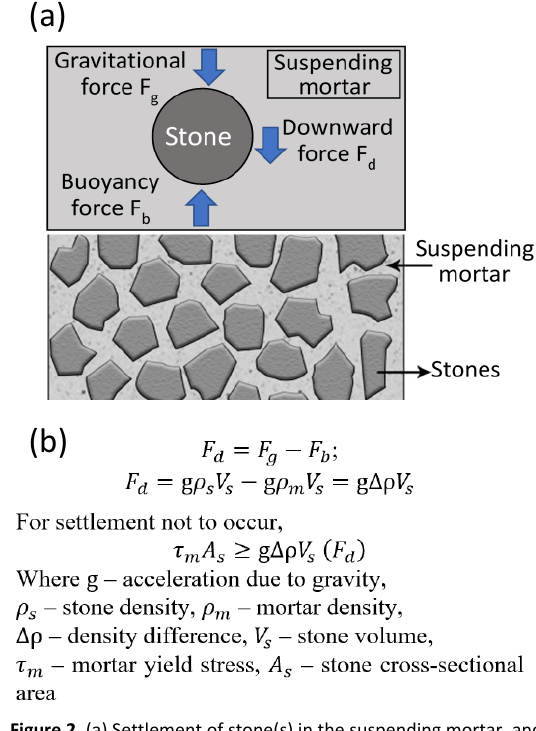
Figure 2. (a) Settlement of stone(s) in the suspending mortar, and (b) the governing equations (reproduced with permission from [20]). Rheo ‐ viscoelastic